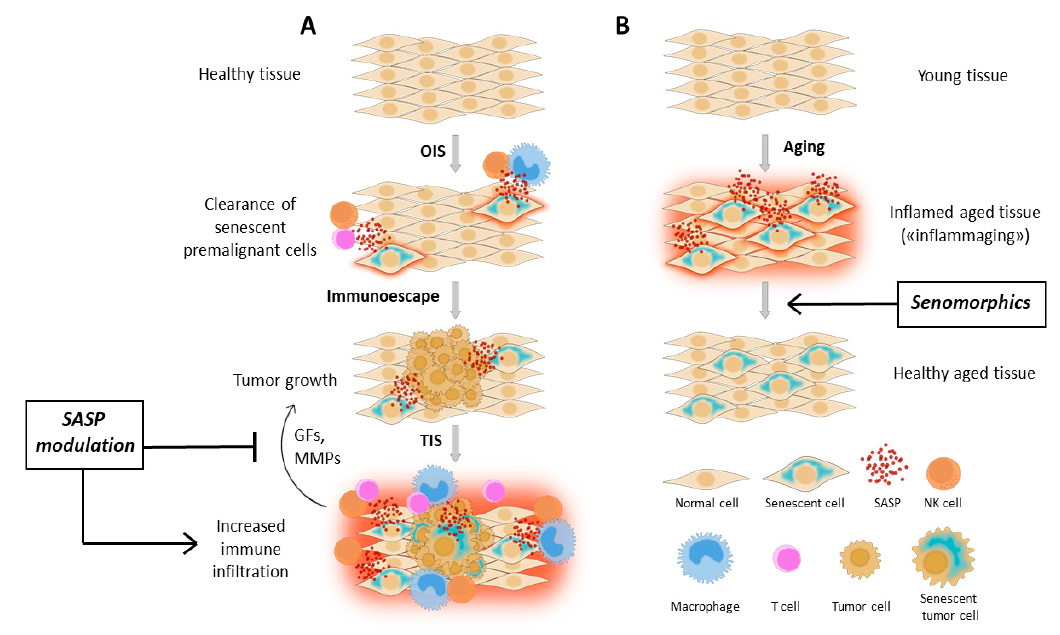
Figure 1. Therapeutic approaches of Senescence-Associated Secretory Phenotype (SASP) modulation